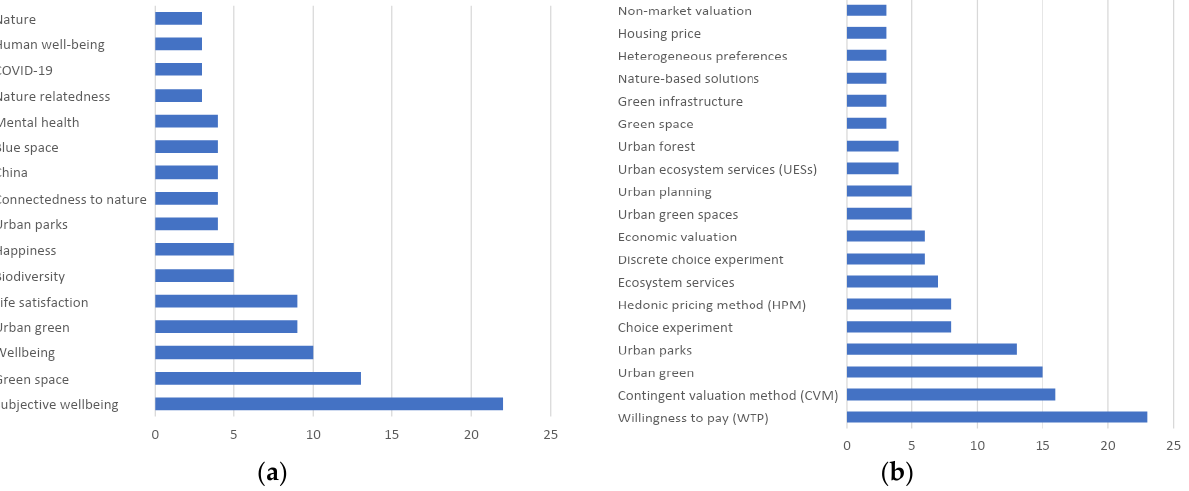
Figure 5. ( a ) Most frequent keywords in SWB studies; ( b ) most frequent keywords in NMV